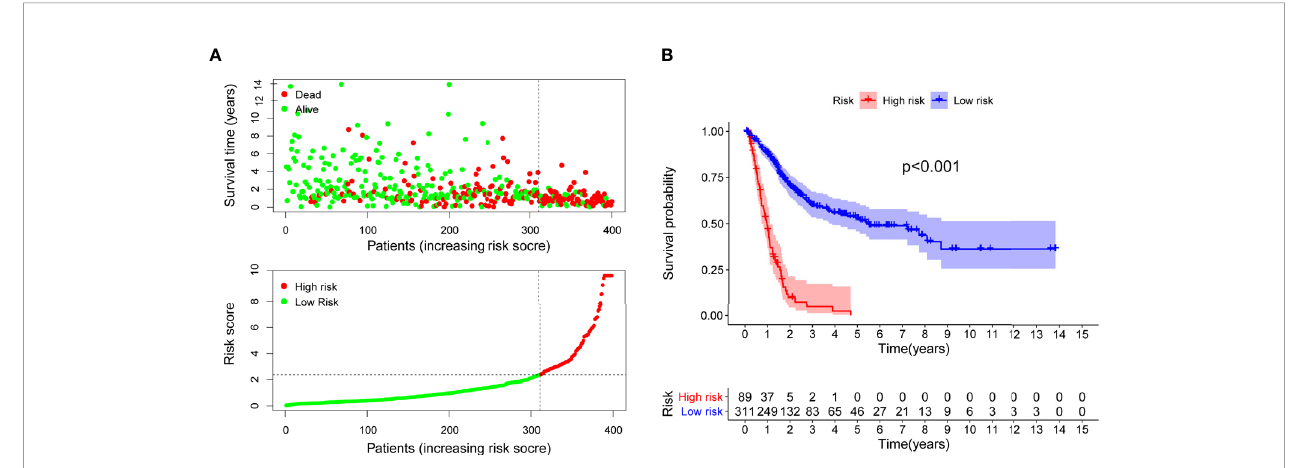
FIGURE 4 | Risk scores (A) and survival outcome (B) of each case are shown. Patients in high-risk group had a shorter survival time tested by the Kaplan-Meier